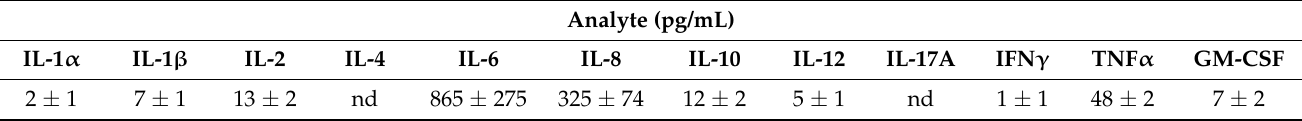
Table 1. Cytokines from OA-SF. Values are presented as mean ± SD ( n = 6). nd = not detected. Analyte